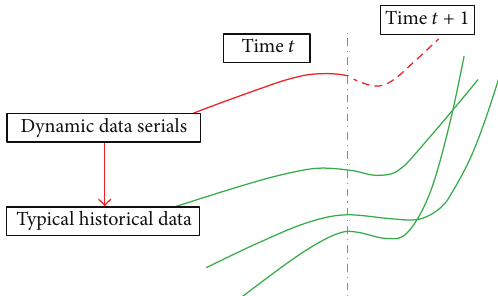
Figure 1: The schematic illustration of nonparametric regression